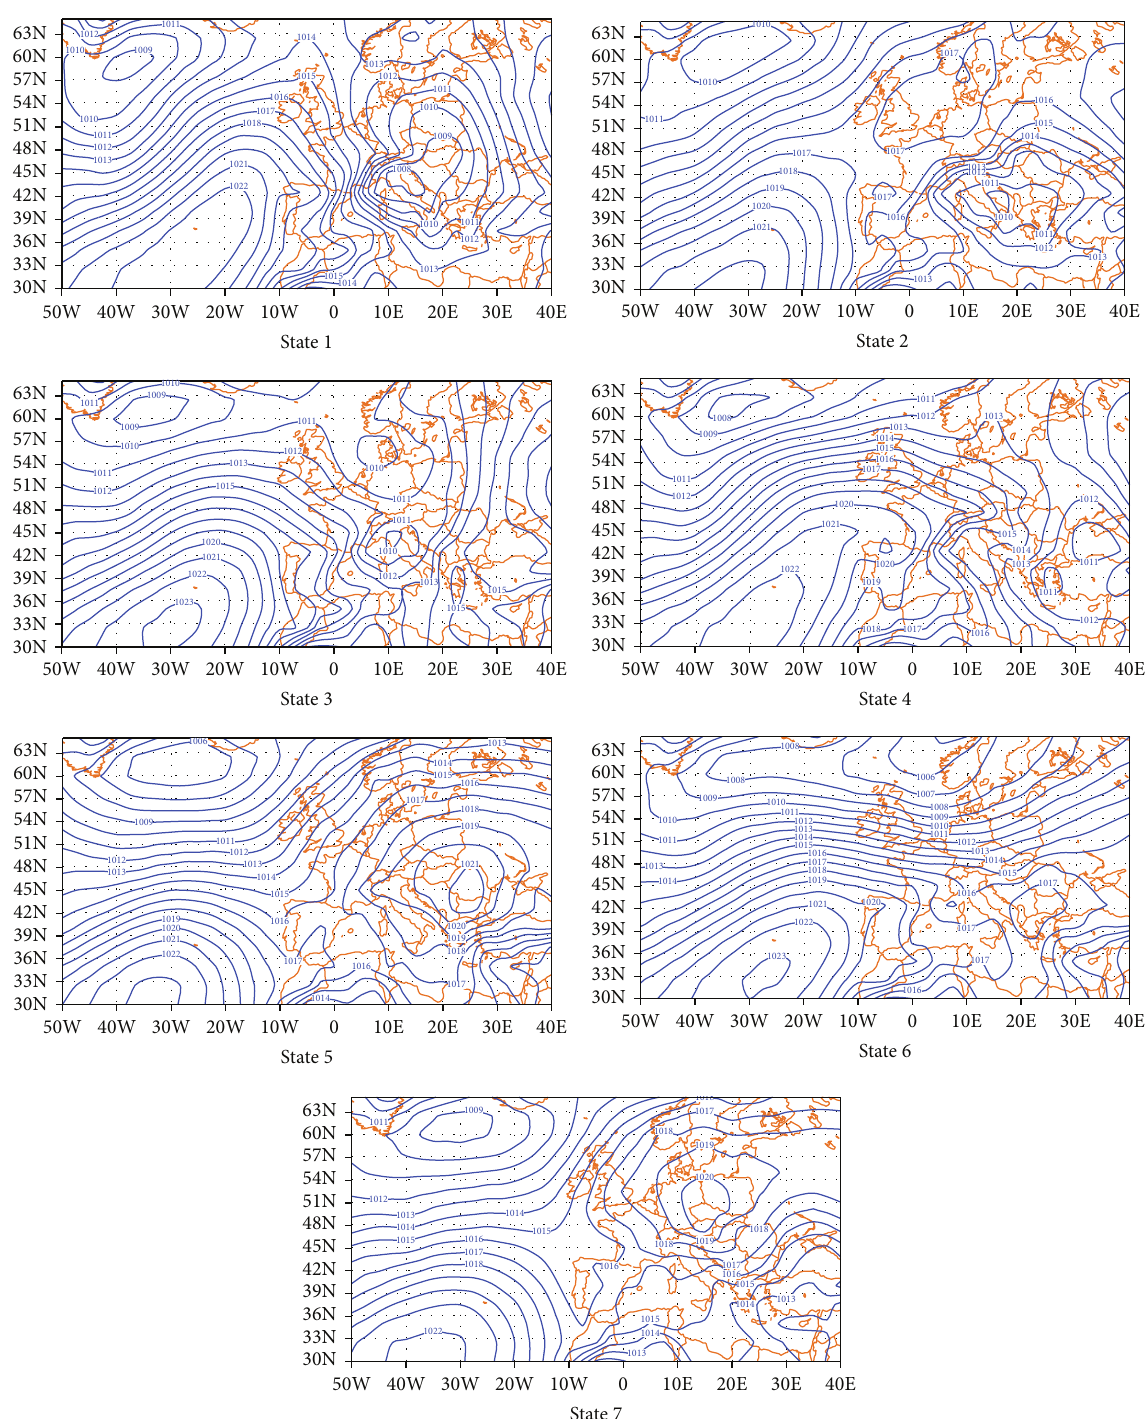
Figure 8: Composite maps of sea level pressure (SLP) corresponding to NHMM with seven states of precipitation. on the entire Danube basin. Also, for the opposite states 1 and 2 a cyclonic field extended on the center and southeast of Europe is